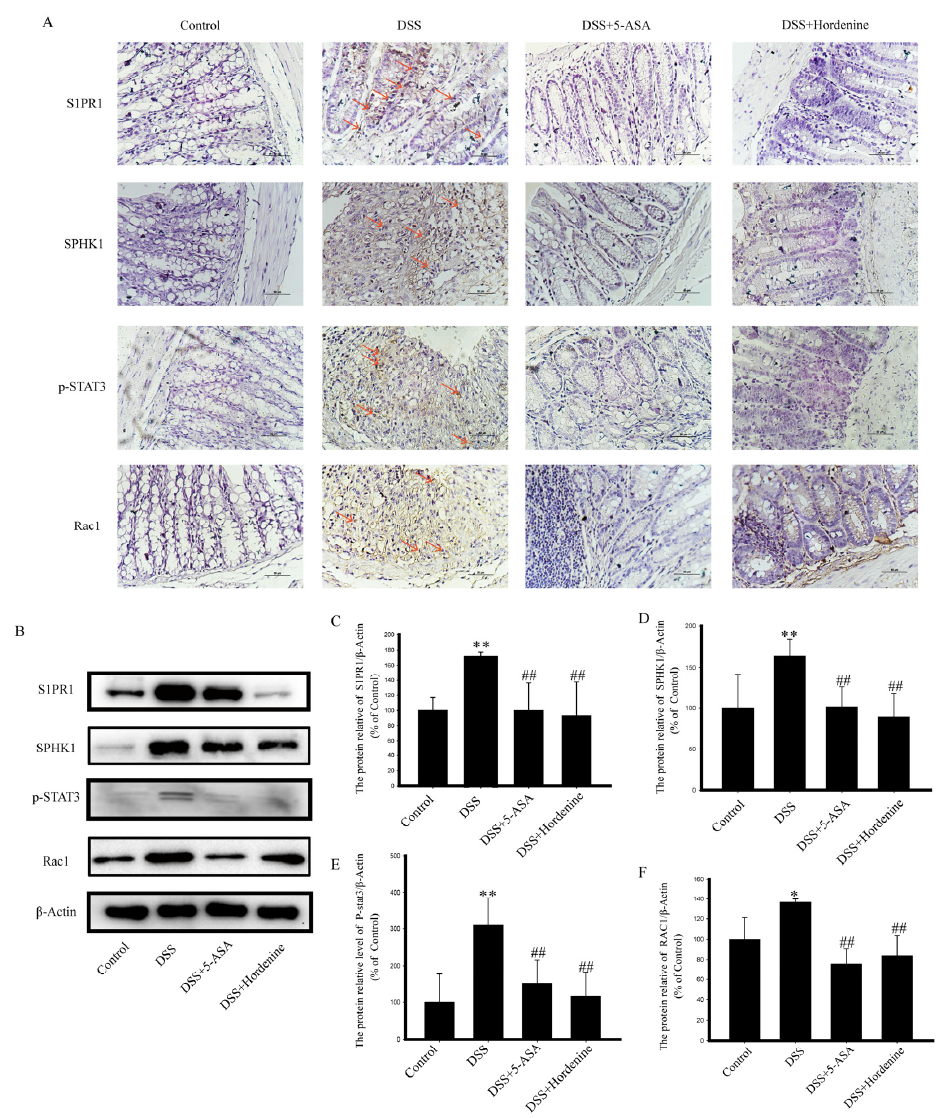
Figure 3. Hordenine (50 mg/kg) inhibited the expression of SPHK1, S1PR1, p-STAT3 and Rac1 in colon tissues. ( A ) Immunohistochemical staining of SPHK1, S1PR1, p-STAT3 and Rac1 in colon tissues. Red arrows point to the positive expression of the target protein, scale bar: 50 μ m. ( B – F ) Western blotting analysis of SPHK1, S1PR1, p-STAT3 and Rac1 levels in colon tissues. * p < 0.05, ** p < 0.01 vs. control group; ## p < 0.05 vs. DSS group.